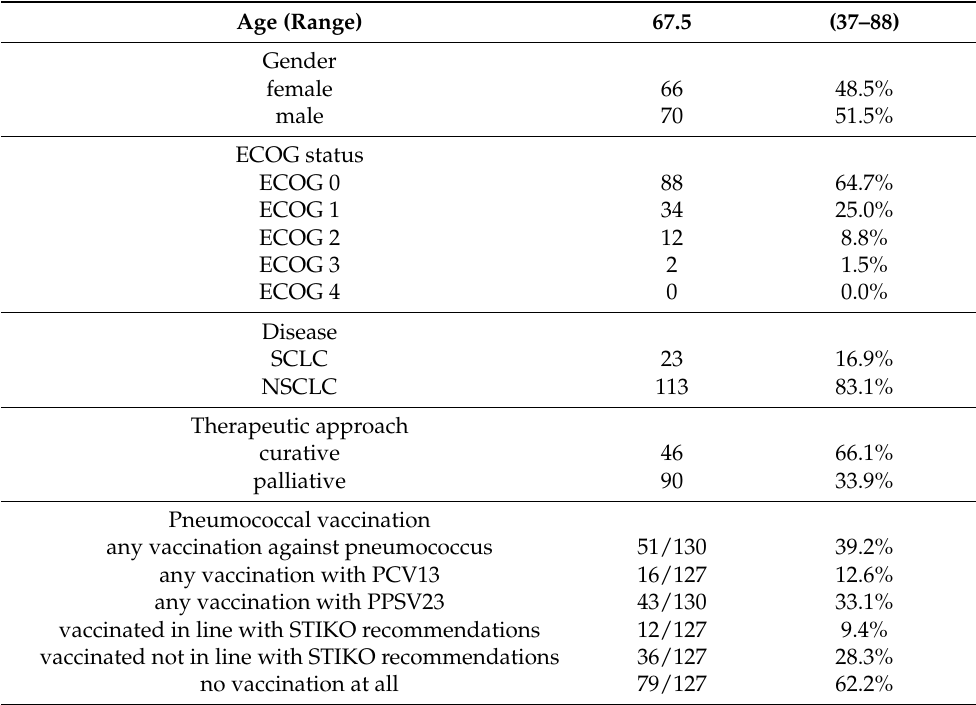
Table 1. Baseline characteristics ( n =